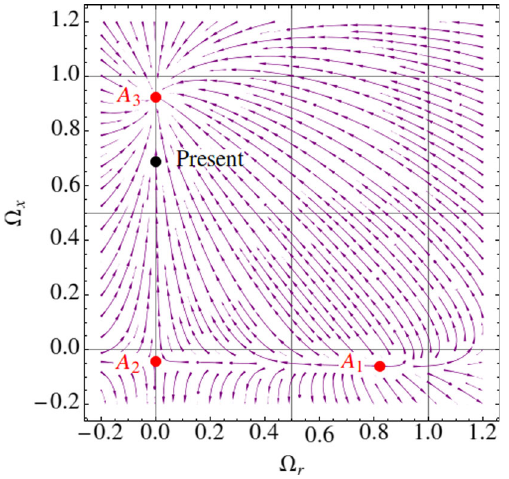
Fig. 1 Phase plot for model Γ 1 T with α = 0 .